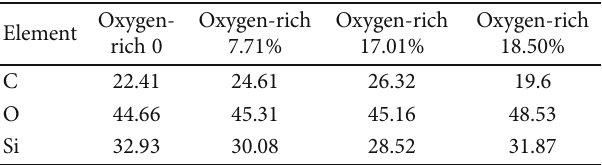
Figure 9: Ceramic layer morphology in the center under di ff erent oxygen-rich conditions. Table 7: Atomic percentage of the ceramic layer in the center under di ff erent oxygen-rich